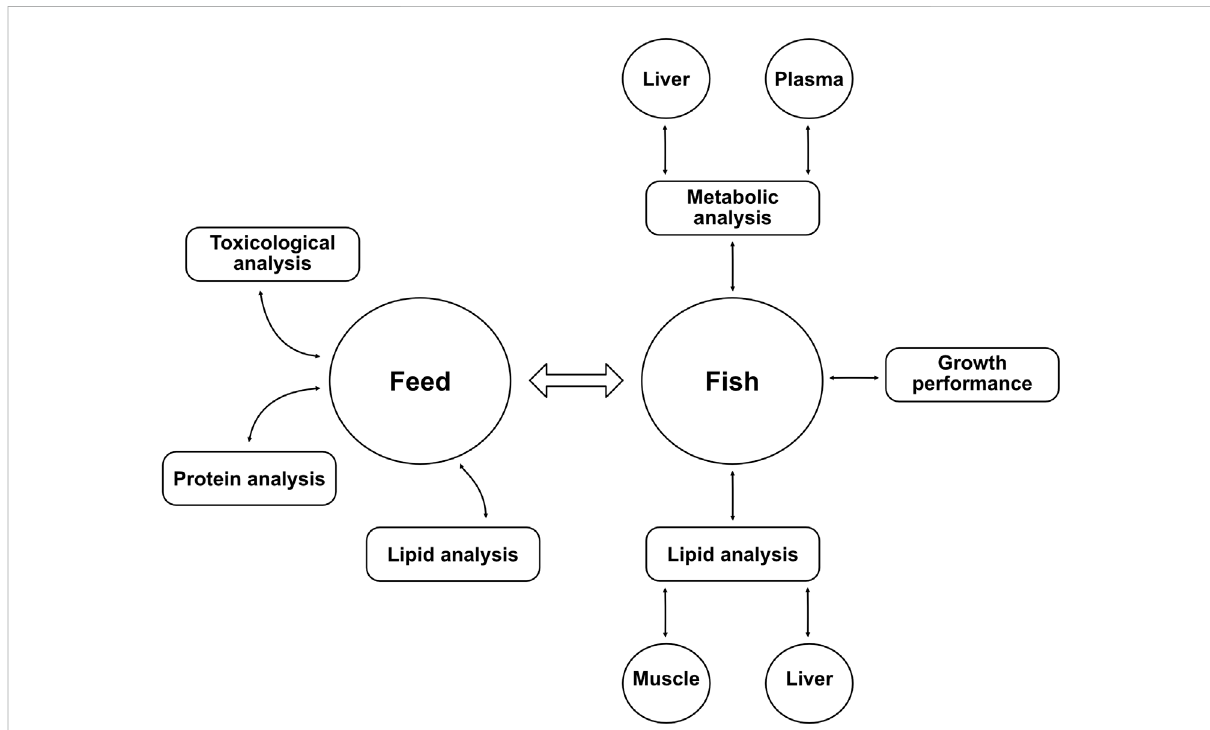
FIGURE 1 Diagram of the different analyses performed in the study. Lipid analyses were achieved with gas chromatography, metabolic analyses were conducted using nuclear magnetic resonance spectroscopy. The growth performance of fi sh was measured with total weight, length, and other parameters shown in Table 4. Protein analysis (crude protein content and amino acid pro fi le) was carried out by Euro fi ns Food & Feed Testing Sweden AB. Toxicological analyses of the yeast biomass included measurement of organic pollutants (polycyclic aromatic hydrocarbons,